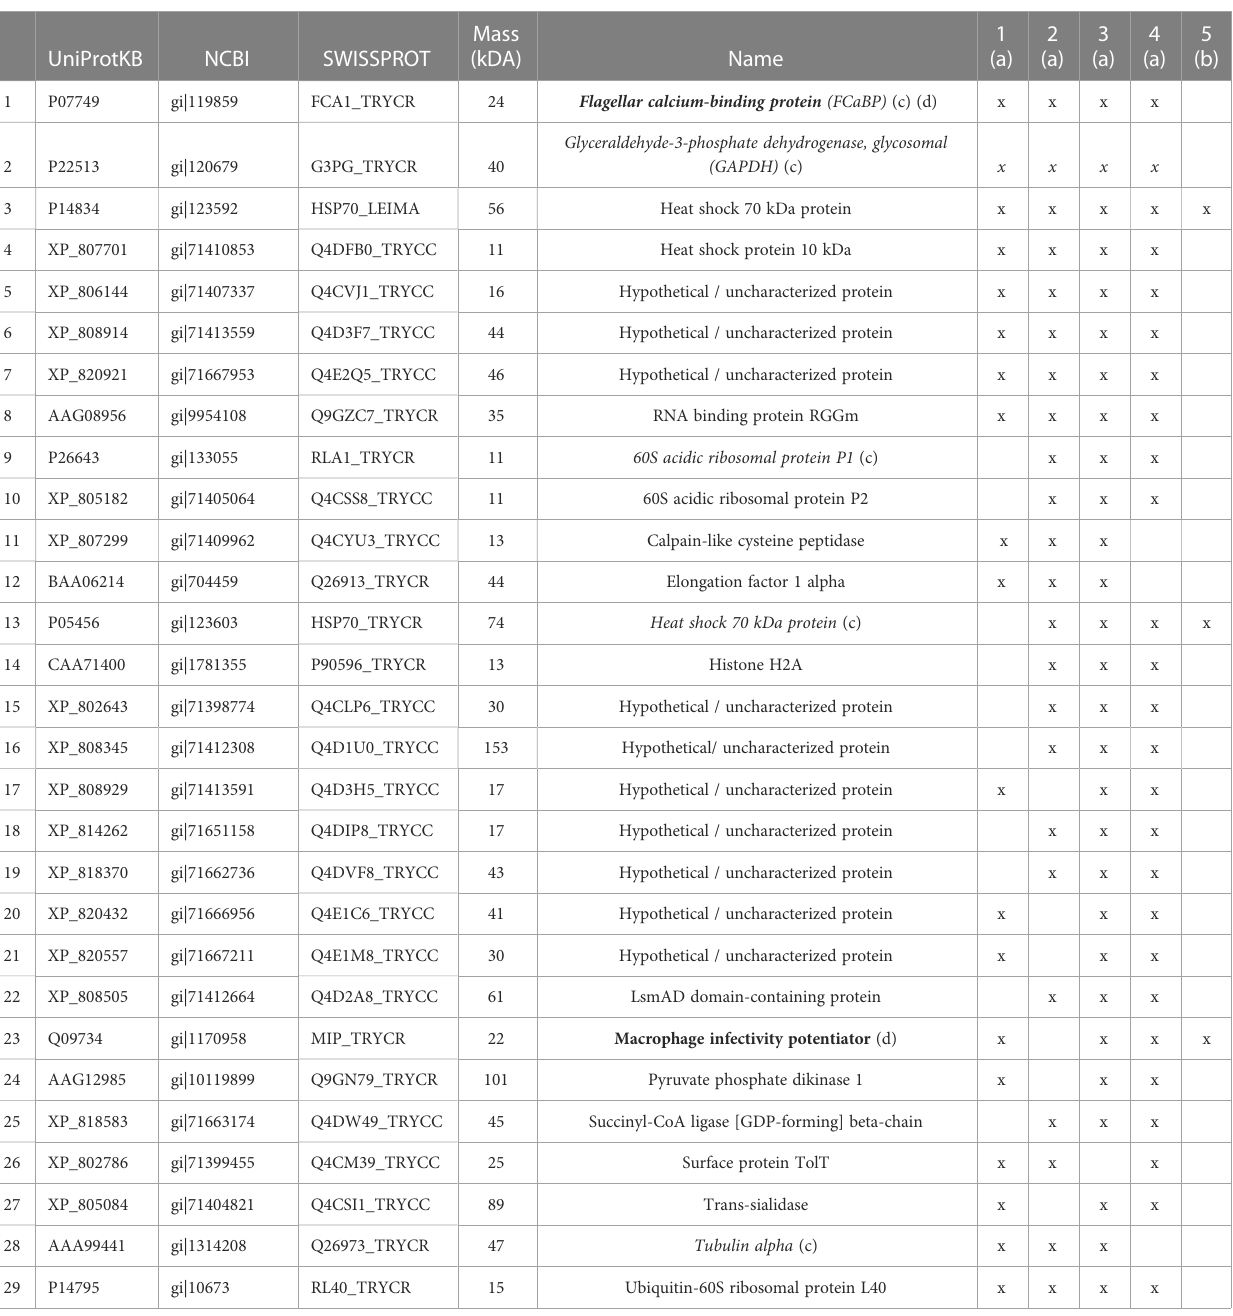
TABLE 1 Proteins identi fi ed in bioactive fractions of trypomastigote OG.